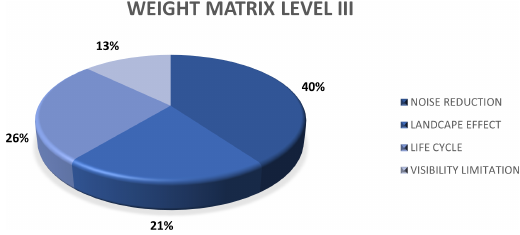
Figure 3: Weights level III (environment)